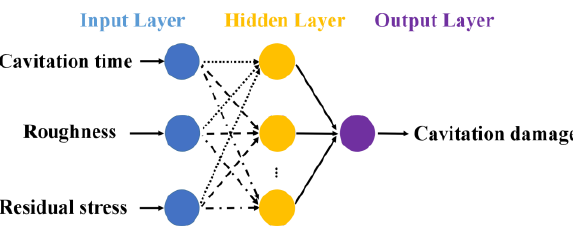
Figure 4. Structure for models with the input nodes of cavitation time, roughness, and residual stress ( T & R & S ). Initial data of the connection weight coefficients of the layers were given by random numbers.